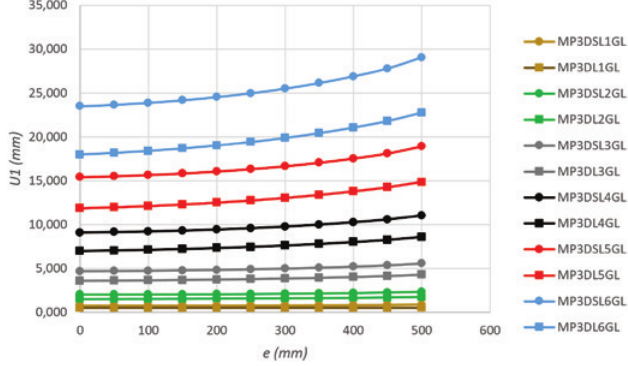
considerada, mesmo com a redução da rigidez para consideração da não linearidade física. No gráfico da Figura 12 tem-se as curvas dos deslocamentos